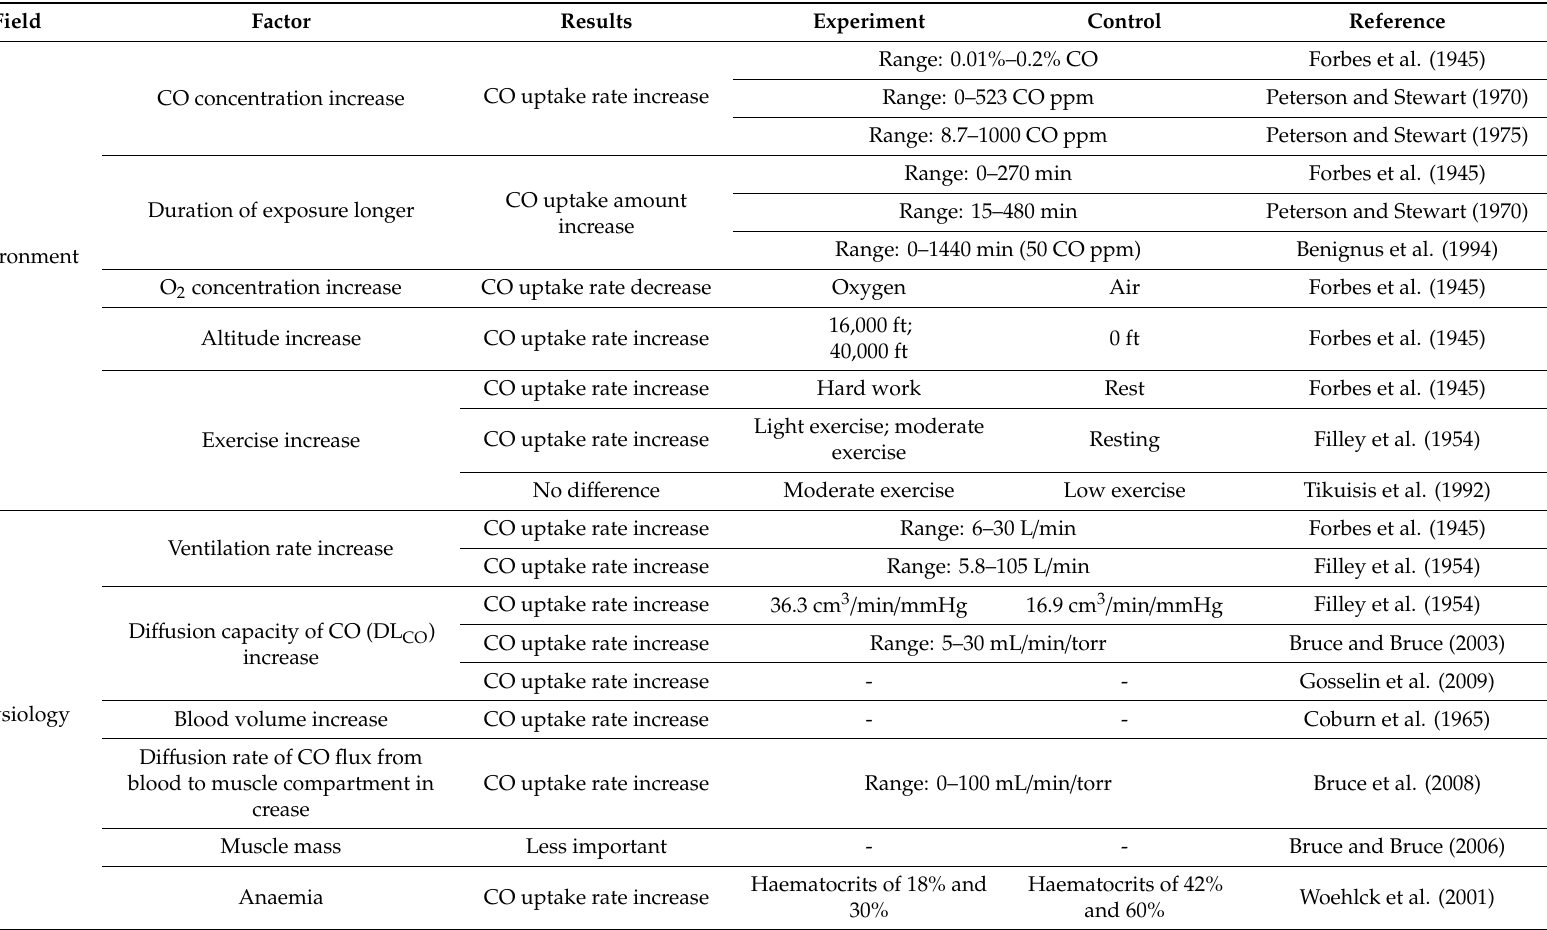
Table 1. The factors related to CO